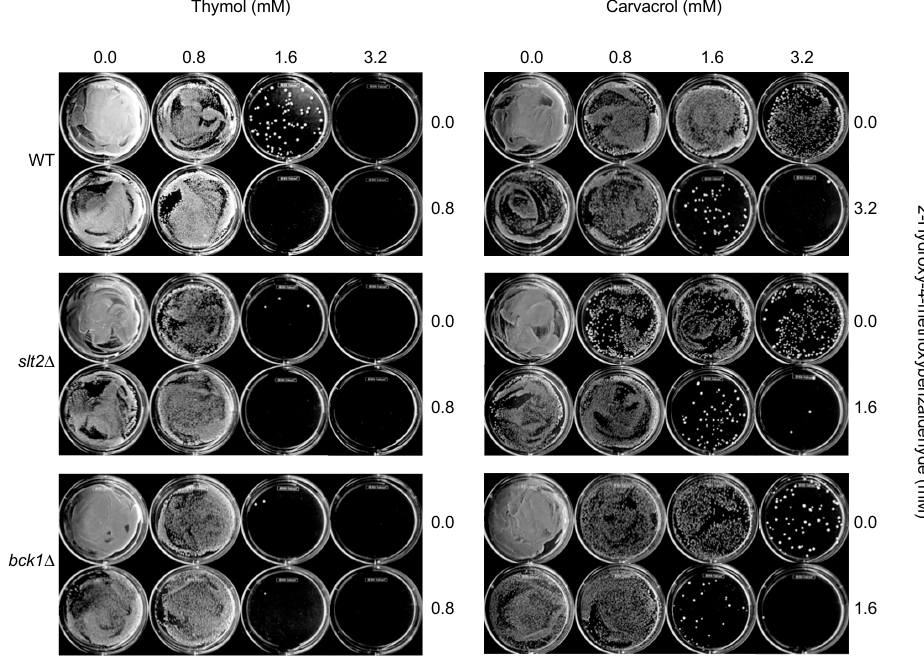
Figure 4. Chemosensitization test in S. cerevisiae (thymol or carvacrol + 2H4M). Exemplary plate bioassay showing co-application of thymol or carvacrol (1.6 to 3.2 mM) with 2H4M (0.8 to 3.2 mM) completely inhibited the growth of S . cerevisiae strains (WT, slt2 Δ , bck1 Δ ).